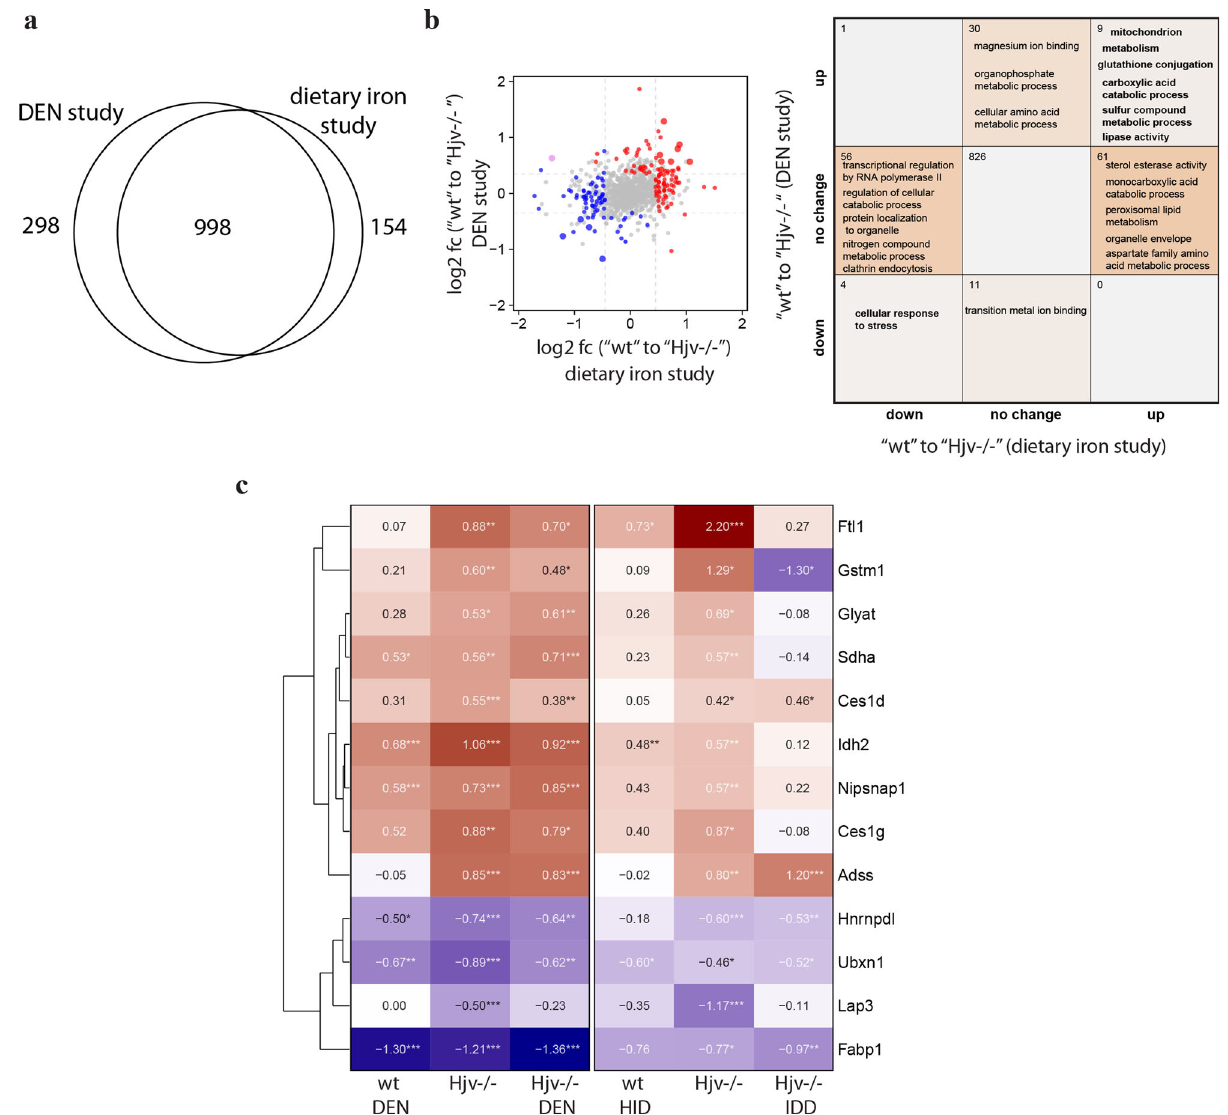
Fig. 8 Mitochondrial proteins and proteins involved in metabolism and glutathione pathways are induced by Hjv de fi ciency, DEN or iron, and corrected by iron depletion. a Venn diagram comparing overlapping quanti fi ed proteins in the DEN and dietary iron studies. b Liver proteomic changes among wild type and Hjv − / − mice between the DEN and dietary iron studies. (Left) Log2 fold-changes (log2 fc) of differentially expressed proteins (Tukey p < 0.05, abs. log2 fold change >0.35). Red = upregulated, blue = downregulated, large point = signi fi cant in both. (Right) Number of signi fi cantly changed proteins and enriched annotations (Fisher ’ s exact test p < 0.05) of respective protein sets. c Heat map of log2 fold-changes compared to wild type control mice of 13 commonly deregulated